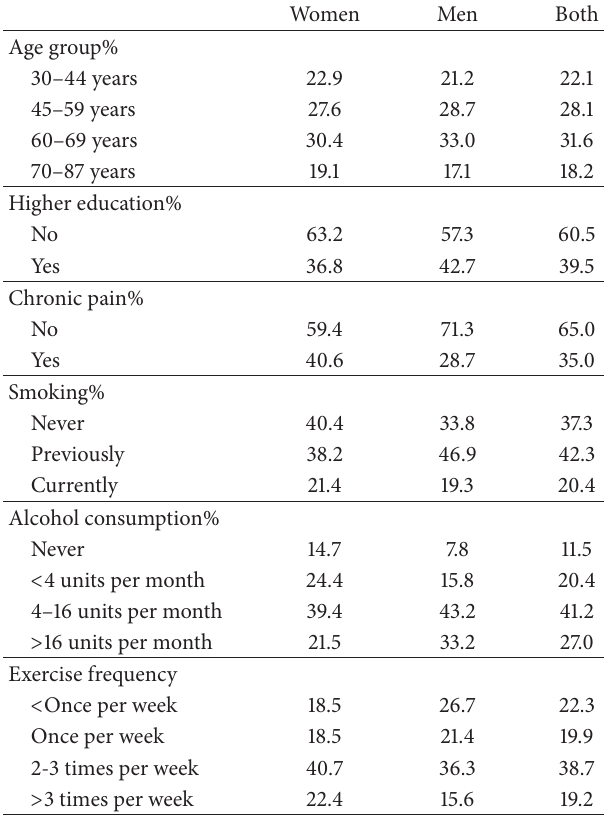
Table 1: Participant representation by demographics and health